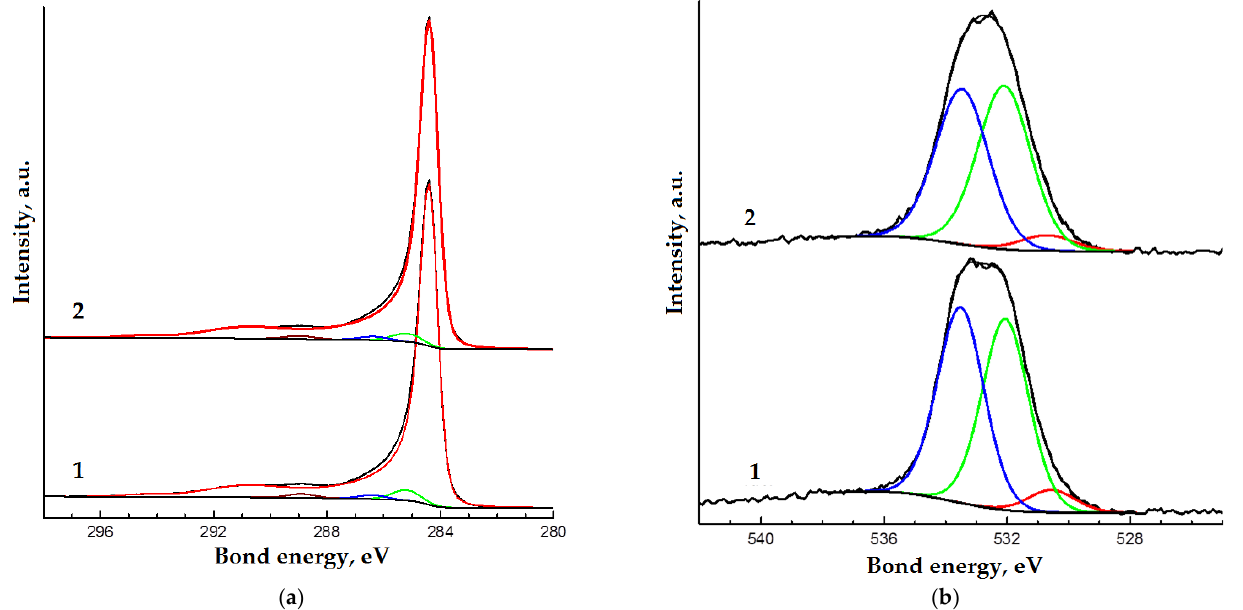
Figure 10. Decomposition into components C1s ( a ) and O1s ( b ) XPS spectra of initial CNTs (1) and CNTs after RESS (2). Table 1. Element concentrations, bond energies and types of bonds in the X-ray photoelectron spectroscopy (XPS) spectra. The Content of the Element, Atomic % Spectrum Bond Energy,